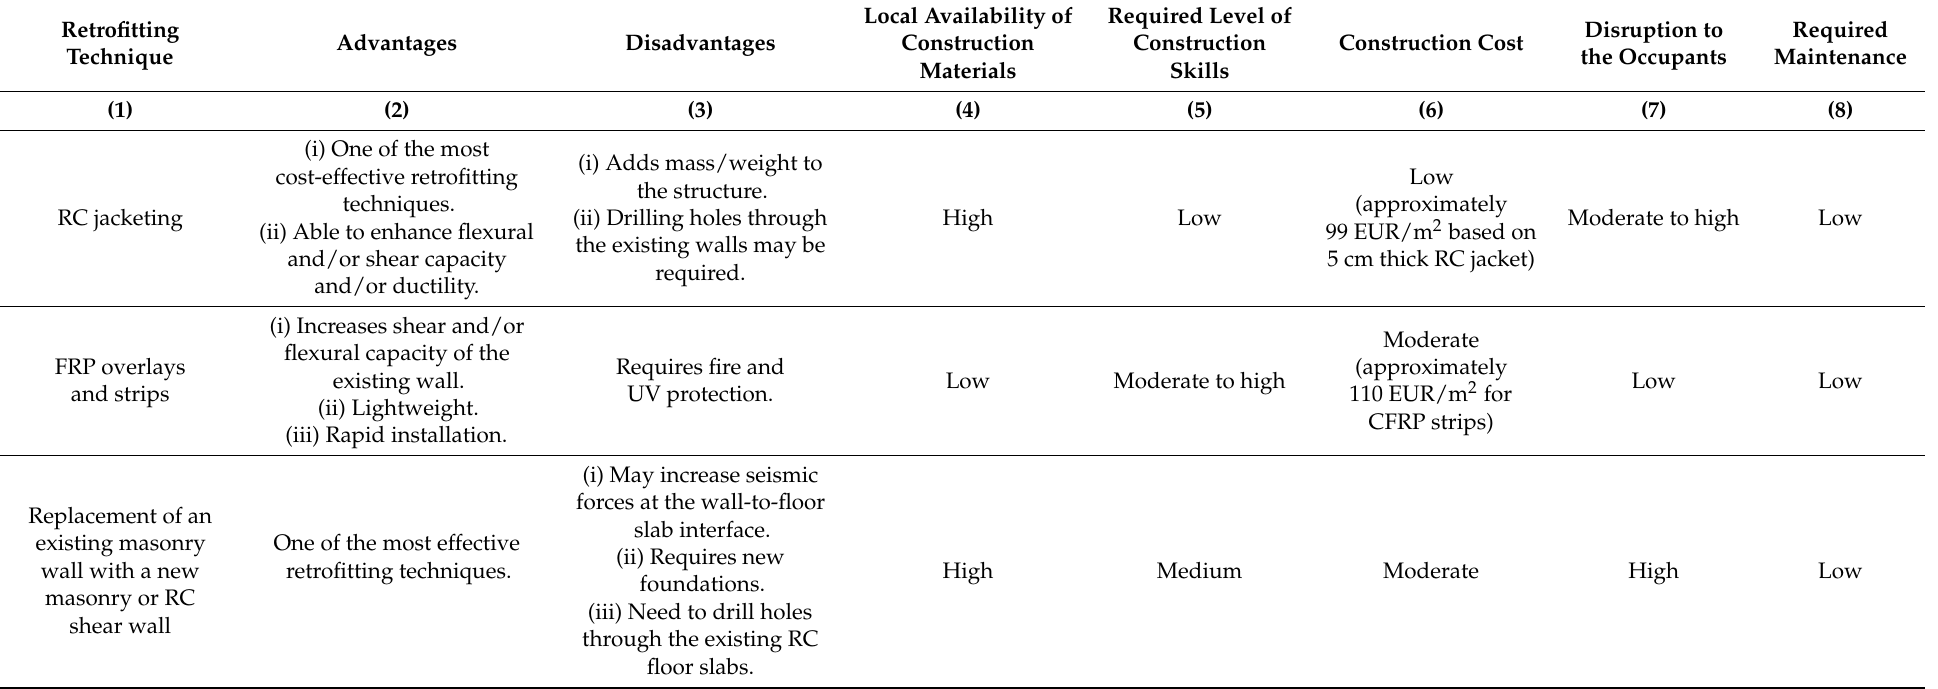
Table 1. A comparison of seismic retrofitting techniques for masonry